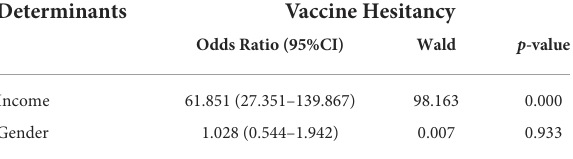
TABLE 3 Determinants of vaccine